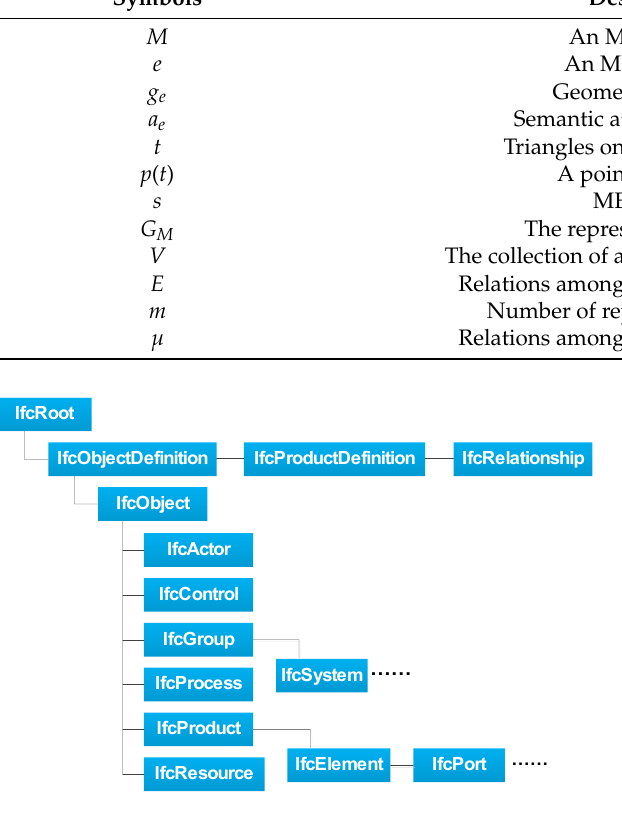
Figure 2. An instance of MEP